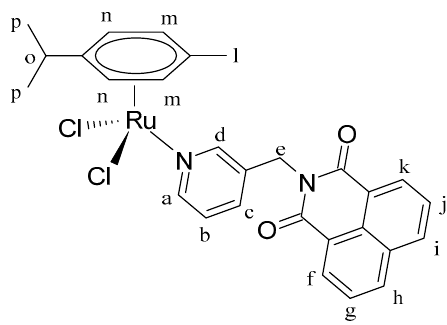
Figure 12. Structure of complex [( η 6-p-cym)Ru(L1)Cl2] (IC1) .